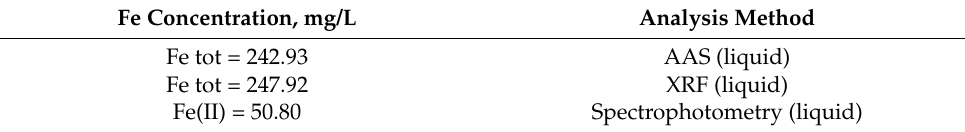
Table 2. Fe concentration from the MS-ION